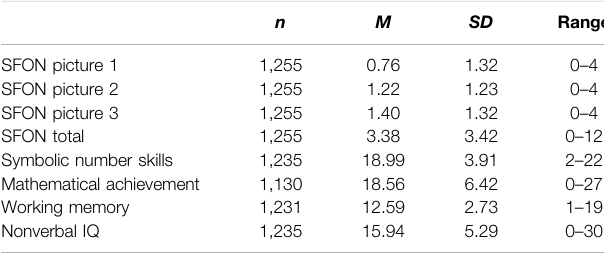
TABLE 2 | Descriptive Statistics for all measures. n M SD